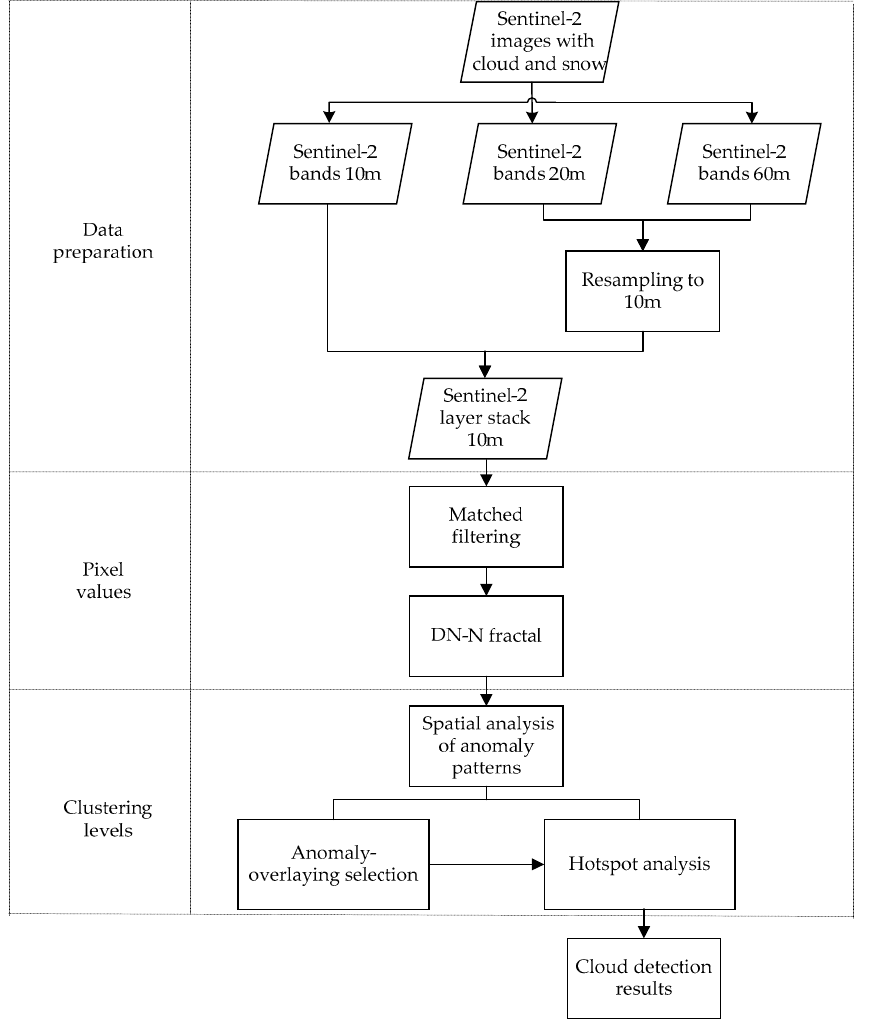
Figure 1. Proposed method framework.